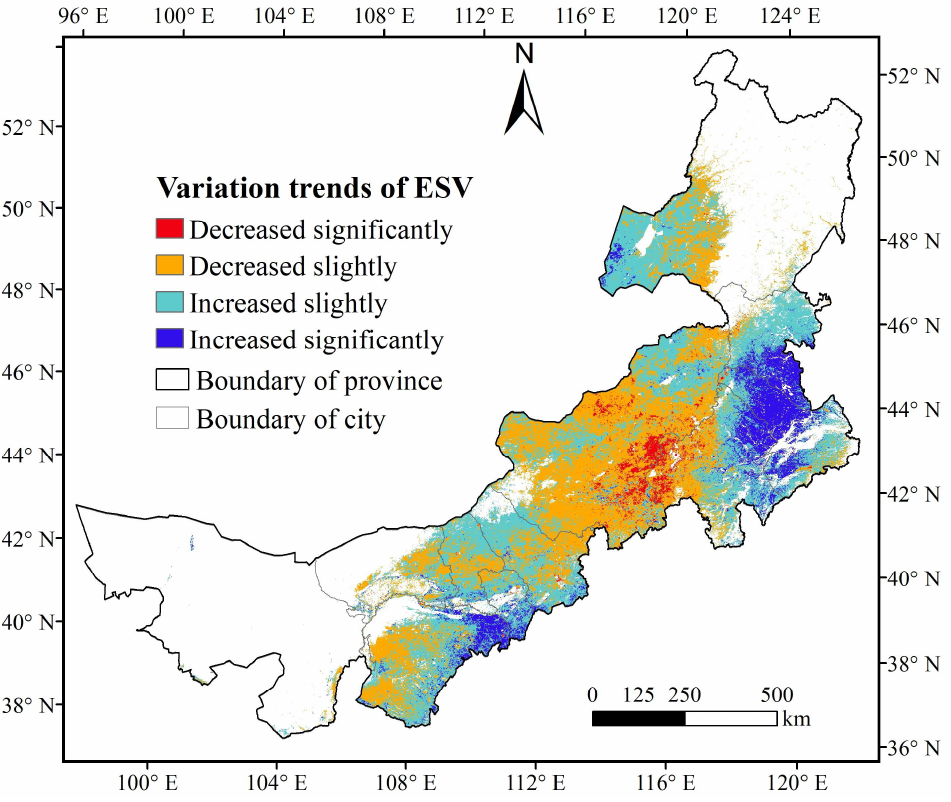
Figure 7. Variation trends of grassland ESV in Inner Mongolia from 2000 to 2019. Table 6. Area ratio with different variation trends of grassland ESV in Inner Mongolia from 2000 to 2019.